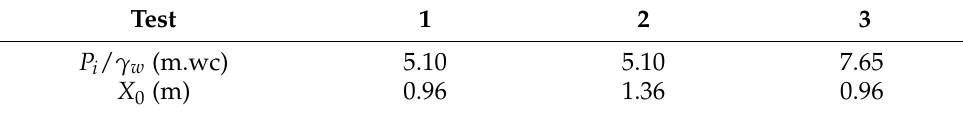
Figure 1. Conceptual scheme of the experimental facility. Table 1. Test